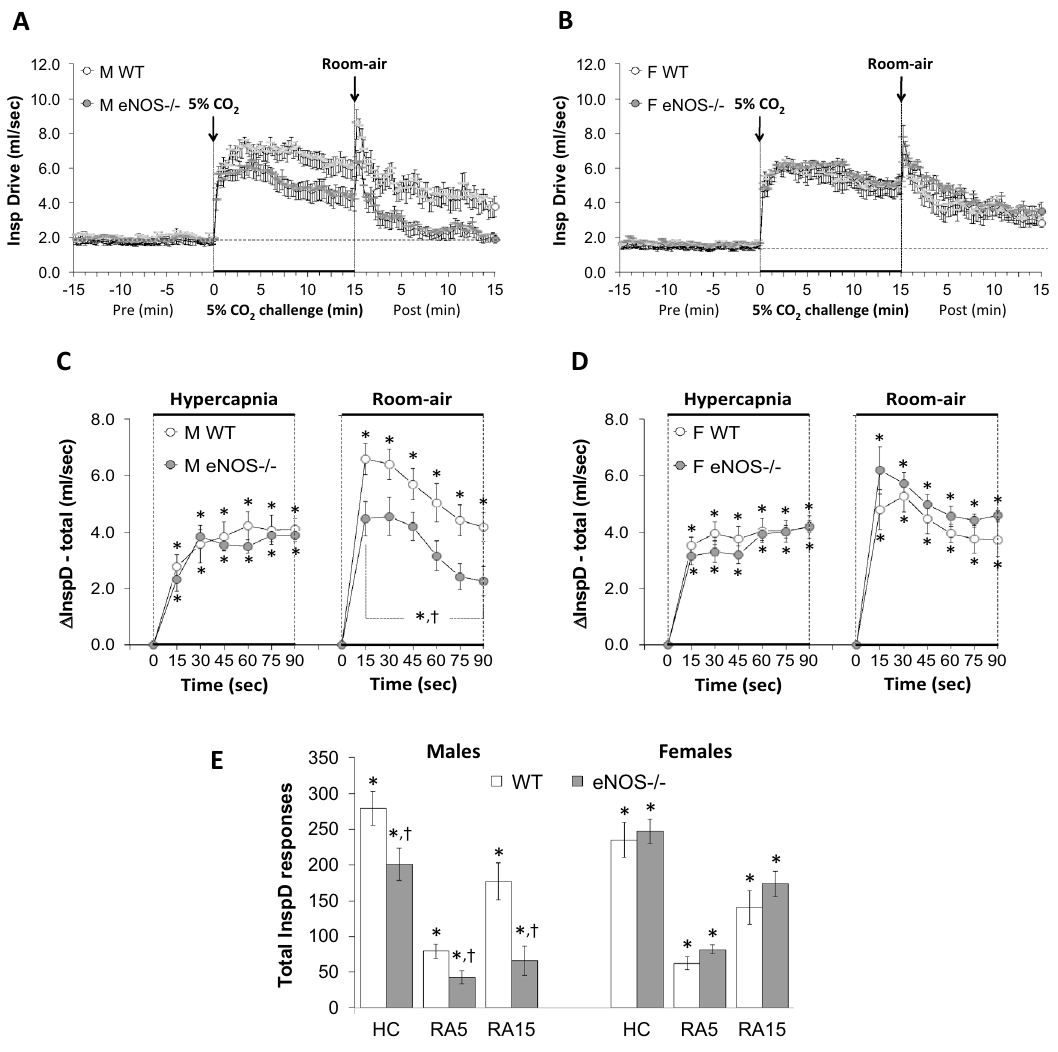
Figure 6. Panels ( A ) and ( B ) Inspiratory drive (tidal volume/inspiratory time, TV/Ti) values before, during a hypercapnic (HC) gas challenge (5% CO 2 , 21% O 2 , 74% N 2 ) and upon return to room-air in male (M) and female (F) wild-type (WT) and eNOS knock-out (eNOS-/-) mice. Panels ( C ) and ( D ) Arithmetic changes in TV/Ti in male and female WT and eNOS-/- mice during the first 90 s of exposure to HC challenge and the first 90 s upon return to room-air. Panel ( E ) Total changes in TV/Ti in male and female WT and eNOS-/- mice during HC challenge and during the first 5 min (RA5) and entire 15 min (RA15) return to room-air. The data are presented as mean ± SEM. * P < 0.05, significant change from pre-values. † P < 0.05, eNOS-/- versus WT within each